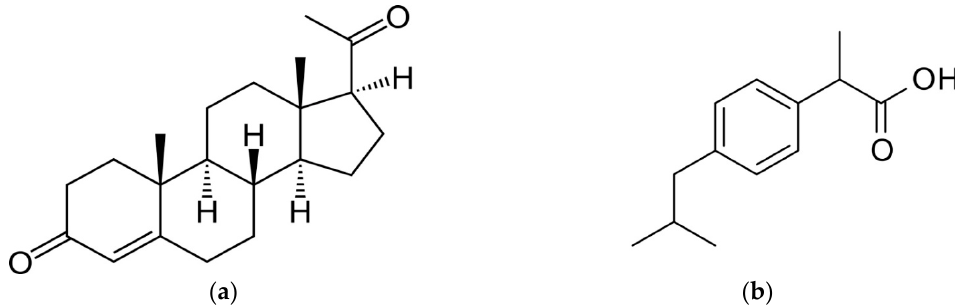
Figure 1. Molecular structures of progesterone ( a ) and ibuprofen ( b ).